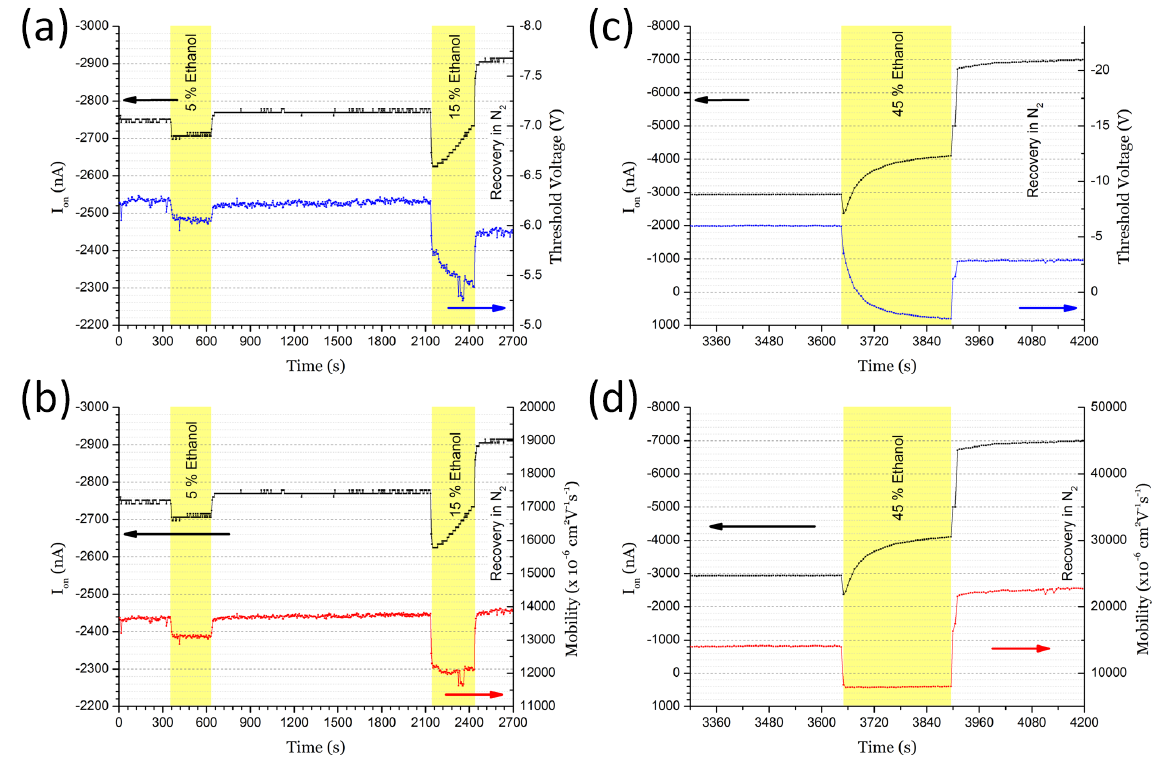
Figure 5. Exposure of PBTTT OTFTs to EtOH. (a) I ON (top, black curve) and V th (bottom, blue curve) versus time under 5/15% p sat EtOH. (b) I ON (top, black curve) and µ (bottom, red curve) versus time under 5/15% p sat EtOH. White regions depict dry nitrogen purge under 500sccm. Shaded regions indicate exposure to different concentrations of ethanol vapour. Left region: 5% p sat (2750ppm) EtOH; right region: 15% p sat (8250ppm) EtOH. (c) Similar to (a) but for exposure to 45% p sat (24750ppm) EtOH. (d) Similar to (b) but under 45% p sat (24750ppm)